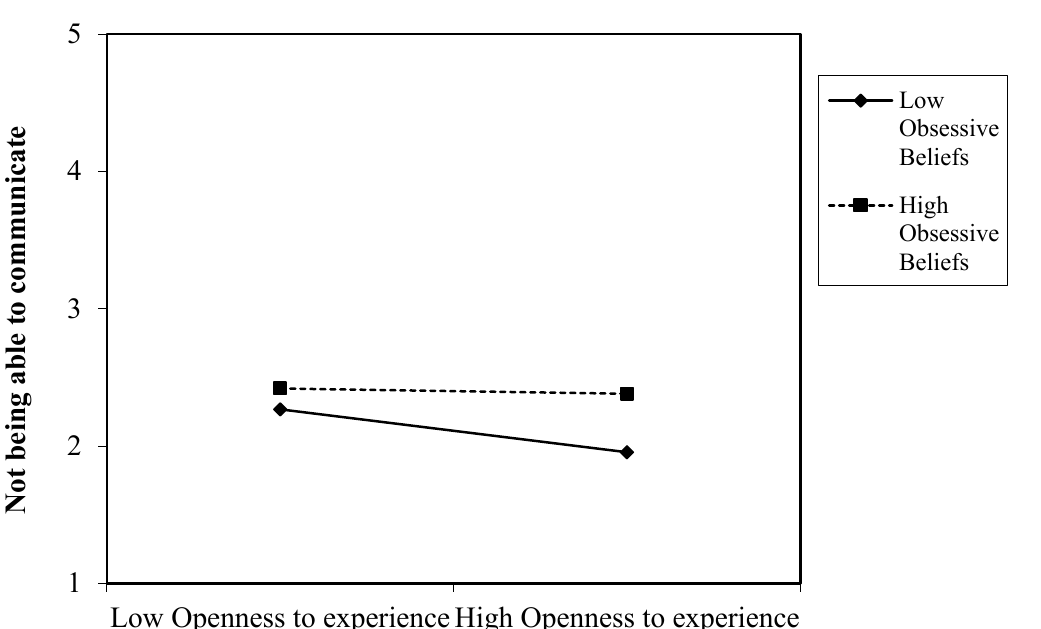
Figure 4. Interaction of openness to experience and obsessive beliefs in predicting the fear of losing connectedness.